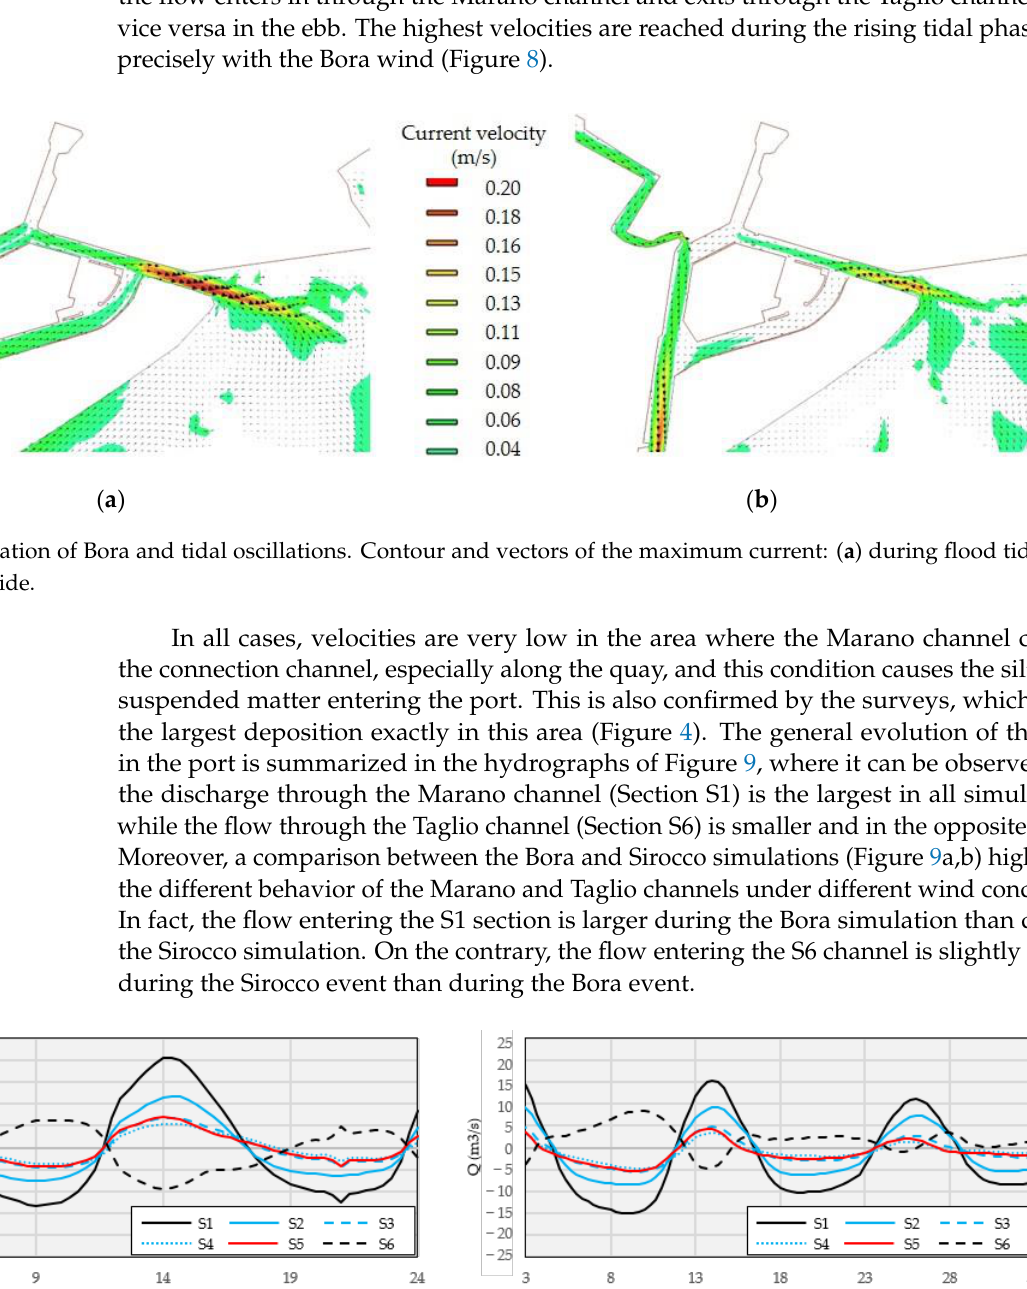
ulation; ( b ) Hydrographs resulting from the Sirocco simulation.